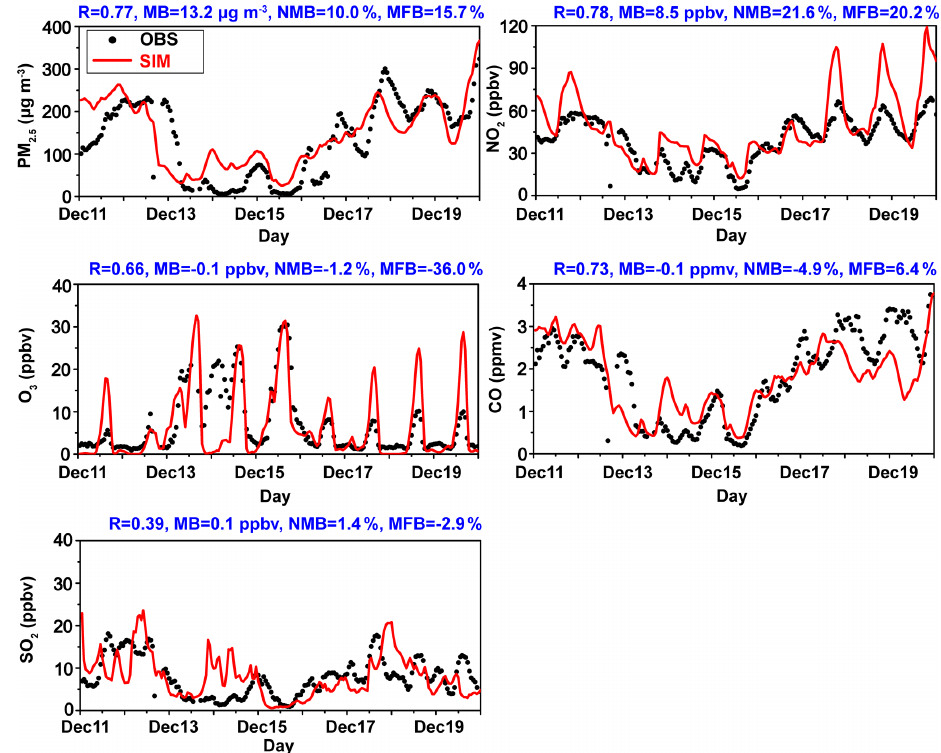
Figure 3. Time series of the observed (black dots) and simulated (red lines) hourly concentrations of PM 2 . 5 (µgm − 3 ), NO 2 (ppbv), O 3 (ppbv), CO (ppmv), and SO 2 (ppbv) in Beijing from 11 to 19 December 2016. The observations and simulations in Beijing were averaged over 12 observational sites and corresponding grid points, respectively. Table 3. Statistical metrics for temperature at 2m ( T 2; ◦ ), relative humidity at 2m (RH2; %), wind speed at 10m (WS10; ms − 1 ), wind direction at 10m (WD10, ◦ ), PBLH (m), SWDOWN (Wm − 2 ), PM 2 . 5 (µgm − 3 ), SO 2 (ppbv), NO 2 (ppbv), CO (ppmv), and O 3